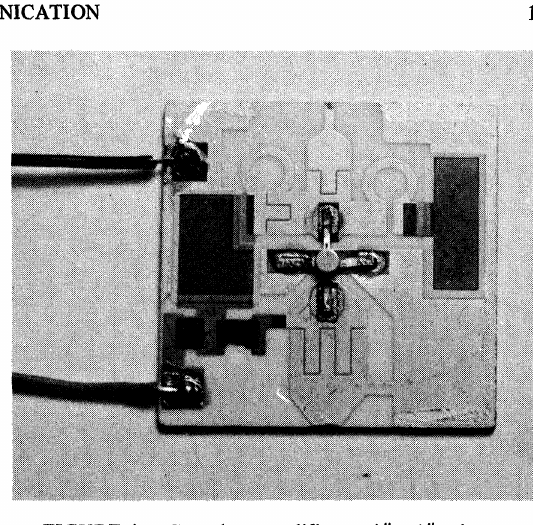
FIGURE 4 Complete amplifier on 1" x 1"